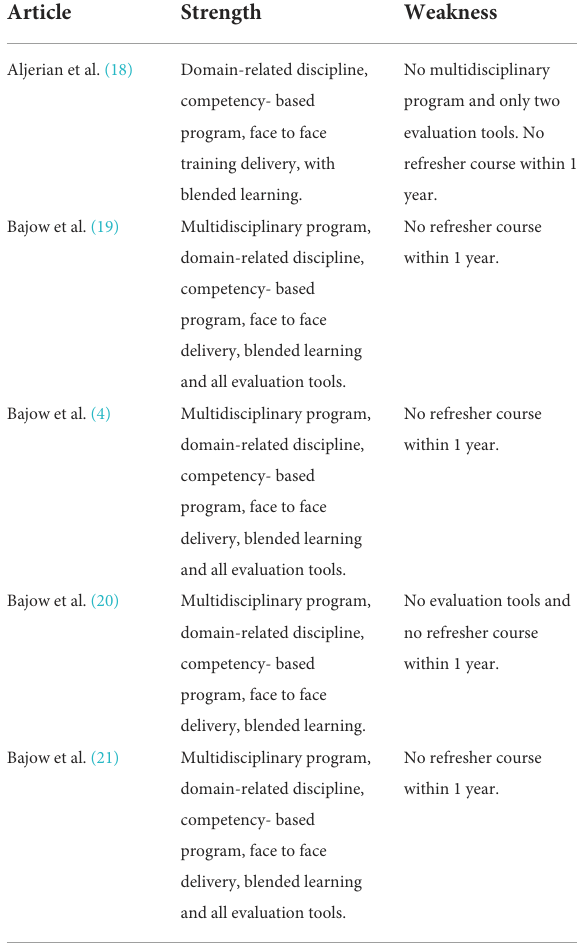
TABLE 4 Strengths and weaknesses of the